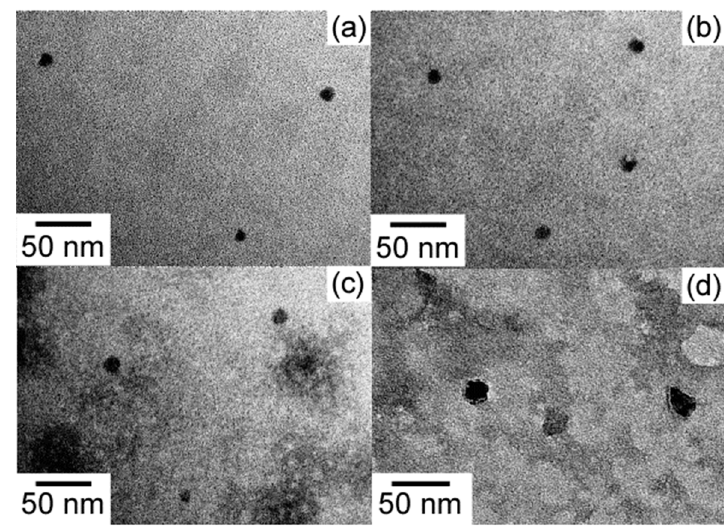
Figure 7. TEM images of P(MPC/DMA x ) with x = 10 ( a ), 19 ( b ), 28 ( c ), and 38 mol % ( d ).